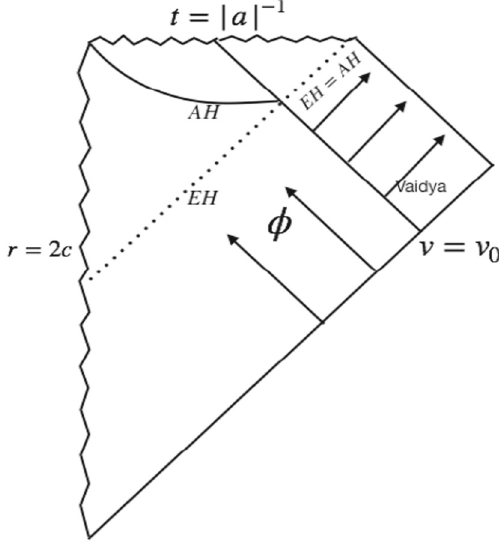
Fig. 3 Penrose diagram for the HMN solution( a (cid:4)= 0 , c (cid:4)= 0 ,α = √ 3 − ) matching to an outging Vaidya solution. There are two singu- 2 | and r = 2 c , where r = 2 c is a naked singularity larities at t = | 1 a